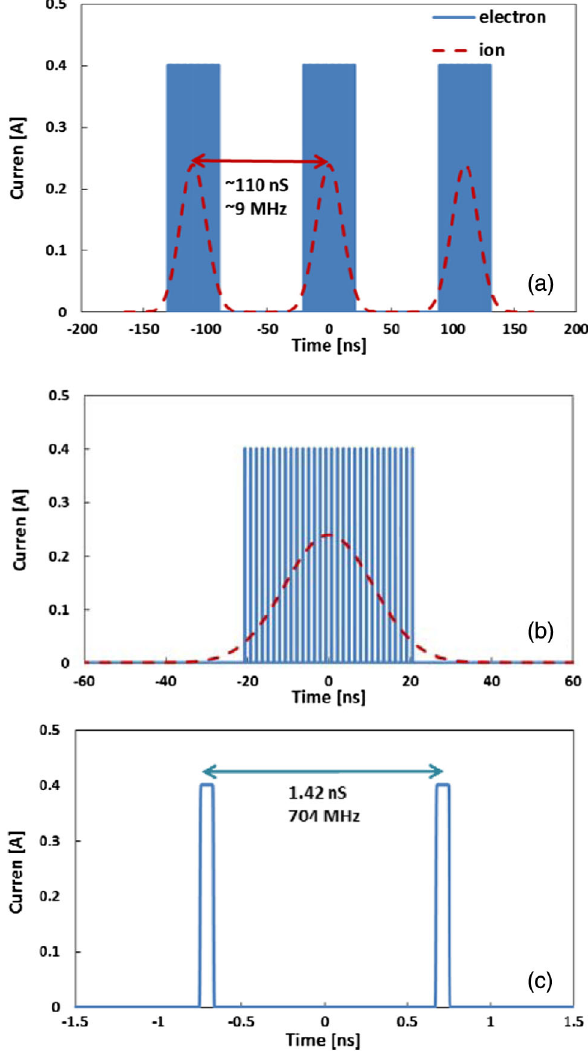
FIG. 1. Electron (blue solid line) and ion (red dashed line) beam pattern. (a) Three 9 MHz bunch trains; (b) one 9 MHz ion bunch with one electron bunch train that consists of 30 flattop electron bunches; (c) two adjacent flattop electron bunches that are spaced 1.42 nS, corresponding to 704